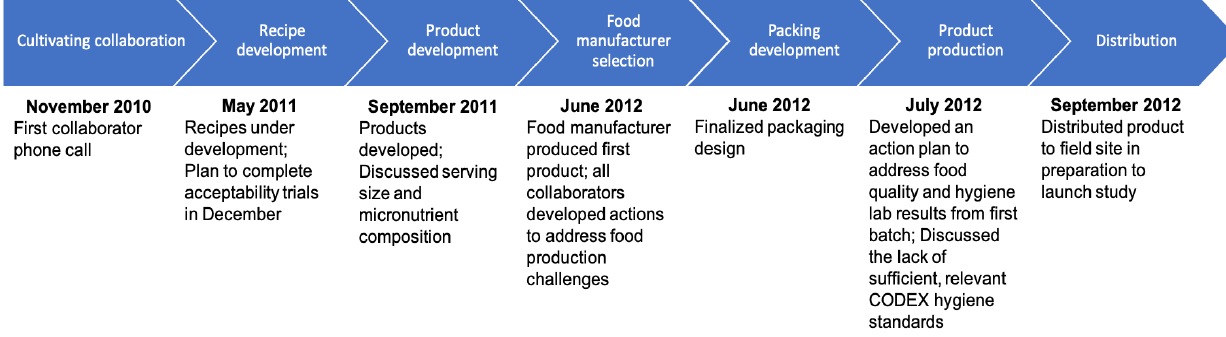
Figure 2. Timeline of project